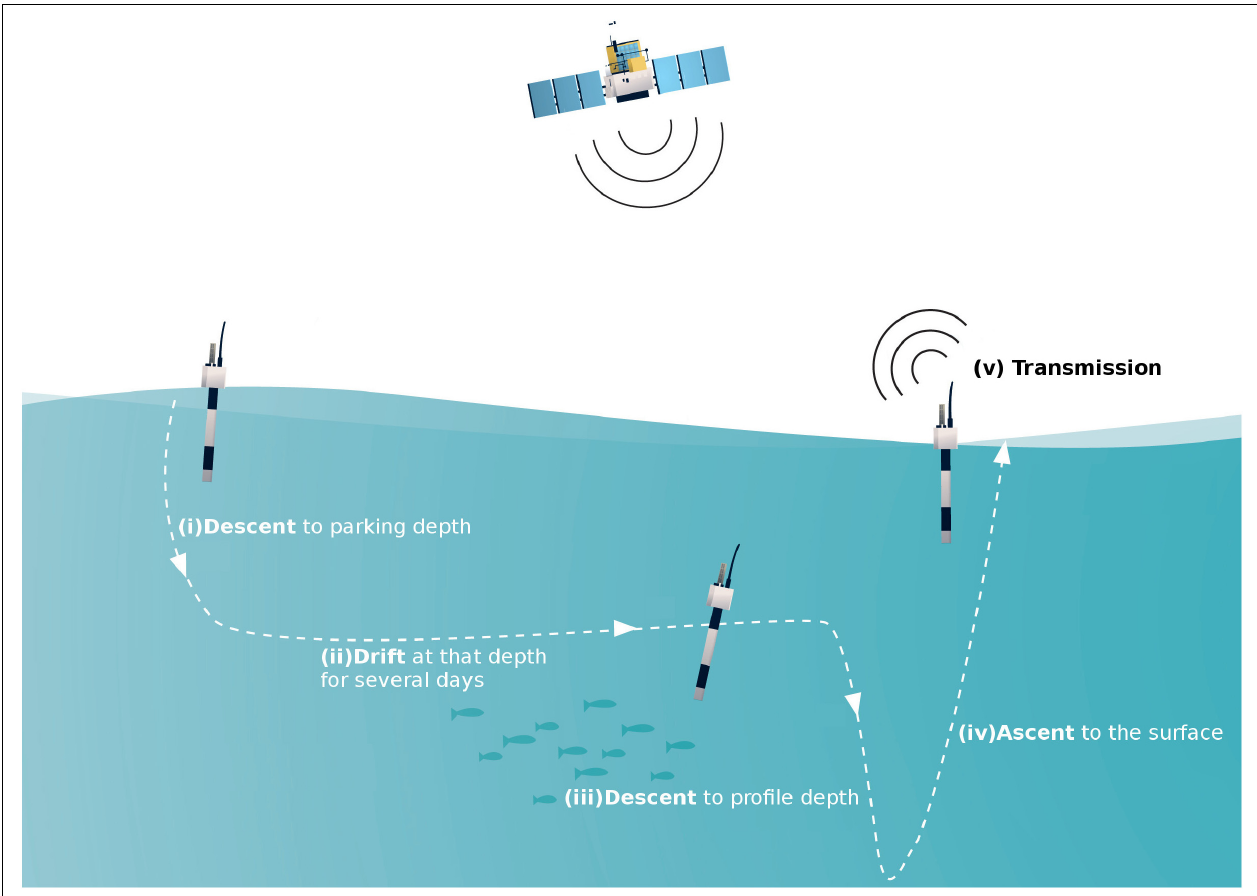
FIGURE 2 | Typical Argo & Deep-Argo cycle (courtesy of Euro-Argo). A cycle is made of five phases: (i) the descent to the drifting depth, (ii) the drift, (iii) the descent to the profiling depth, (iv) the ascent (also named the profile), and (v) the